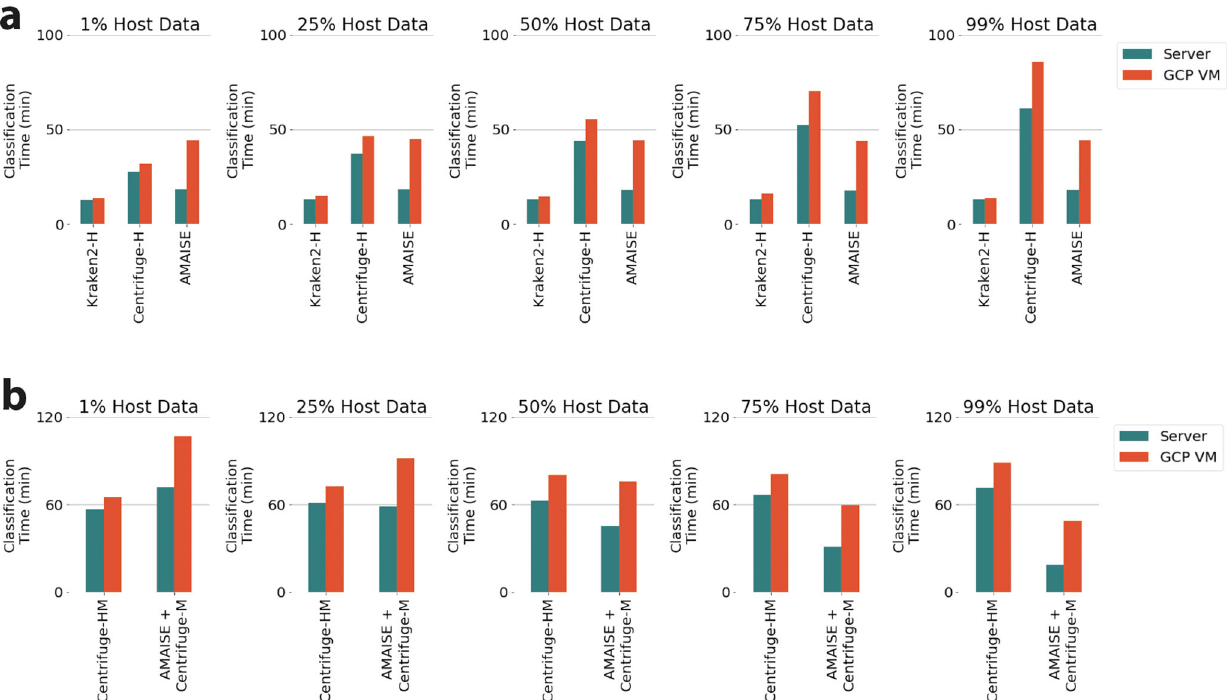
Fig. 5 Classi fi cation time comparison of all methods in two different computational environments. a AMAISE ’ s speed is more affected by the change in computational environment than Kraken2-H and Centrifuge-H, but AMAISE is still faster than Centrifuge-H on test sets with host percentages exceeding 25%. b The pipeline including AMAISE and Centrifuge-M is faster than Centrifuge-HM on test sets with host percentages exceeding 25%.